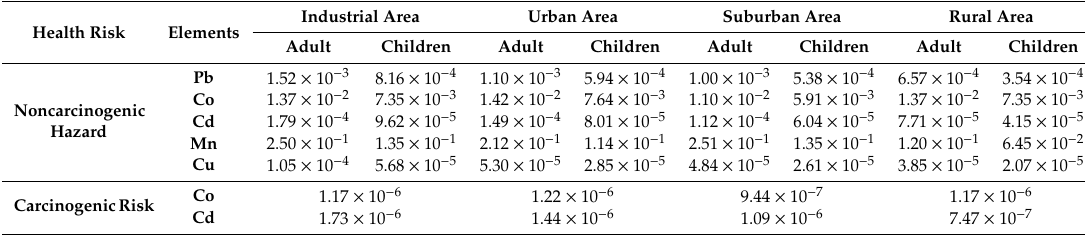
Table 5. Hazard quotient (HQ) and increased lifetime cancer risk (ILCR) for heavy metals in PM 2.5 from industrial, urban, suburban, and rural areas during